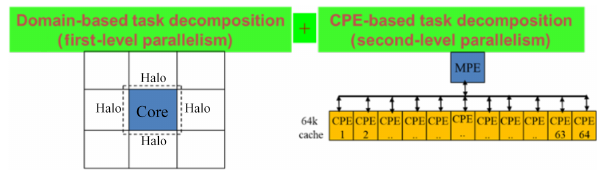
Table 2. Power efficiency of some major